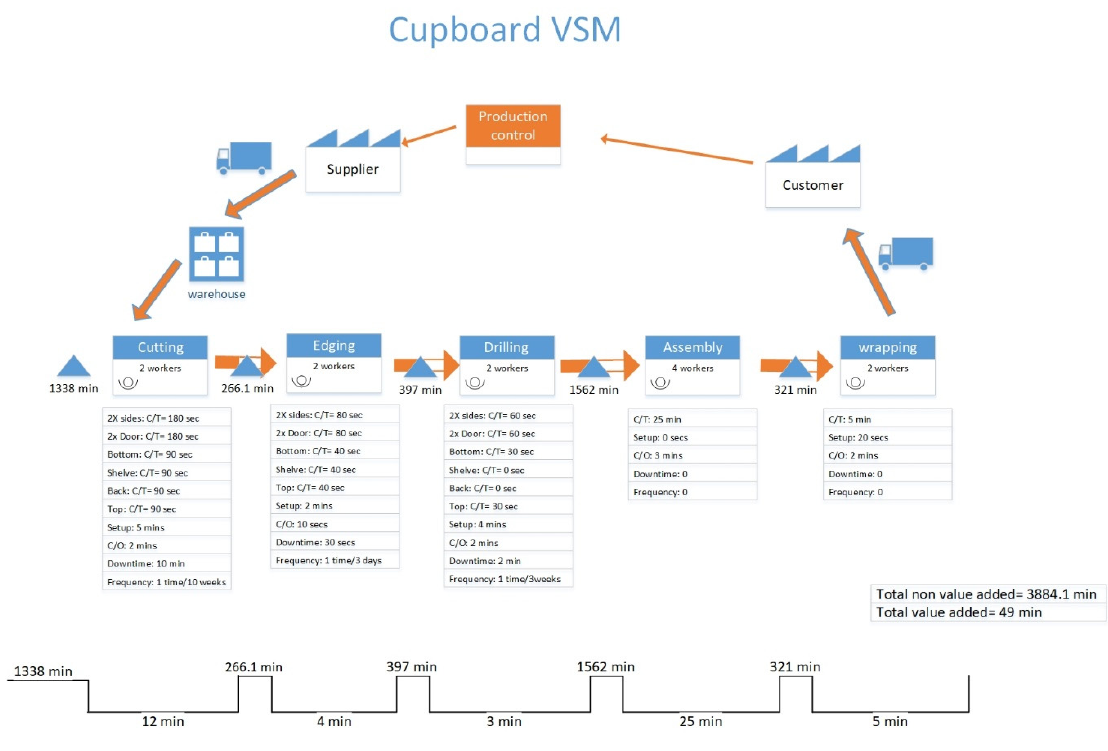
Figure 5. Future-state VSM.